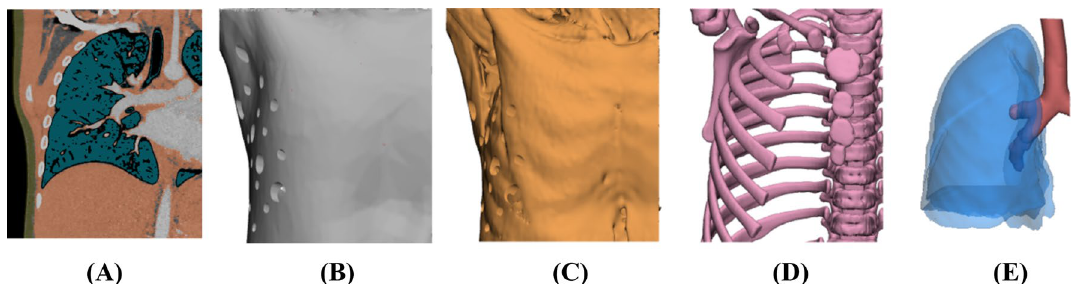
Figure 2. CT image segmentation and 3D modeling for 3D rehearsal simulation phantom: ( A ) left lobe of the lung, ( B ) skin, ( C ) muscle, ( D ) bone, and ( E ) airway and lung. (Mimics 20.0 and 3 ‐ matic 12.0, Materialise NV, Leuven,